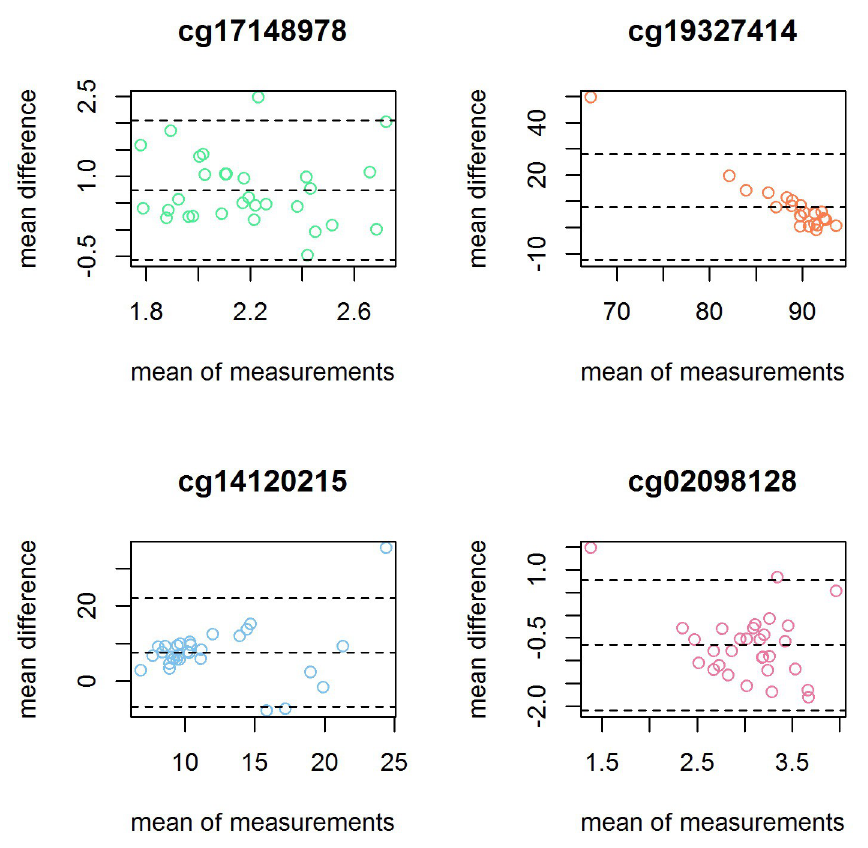
Fig 3. Bland-Altman plots showing the mean difference between methods (y-axis) versus the mean between methods (x-axis) for each CpG site tested for technical validation.